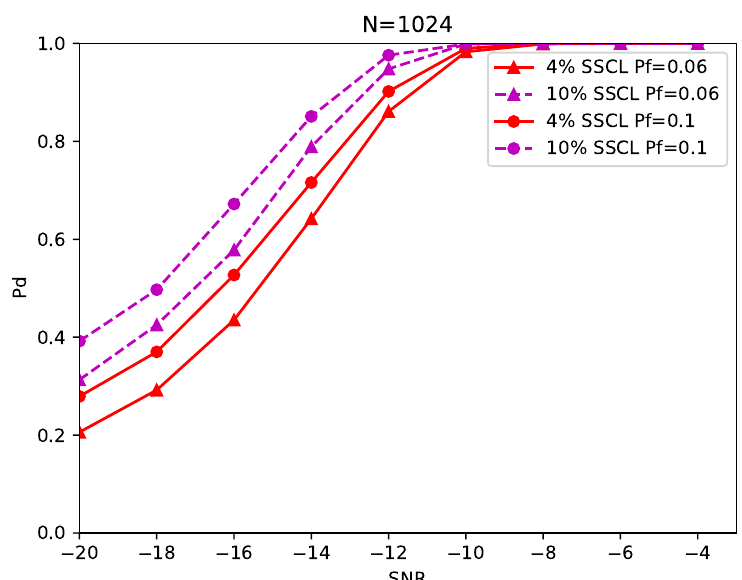
Figure 7. Detection probability when N = 512.